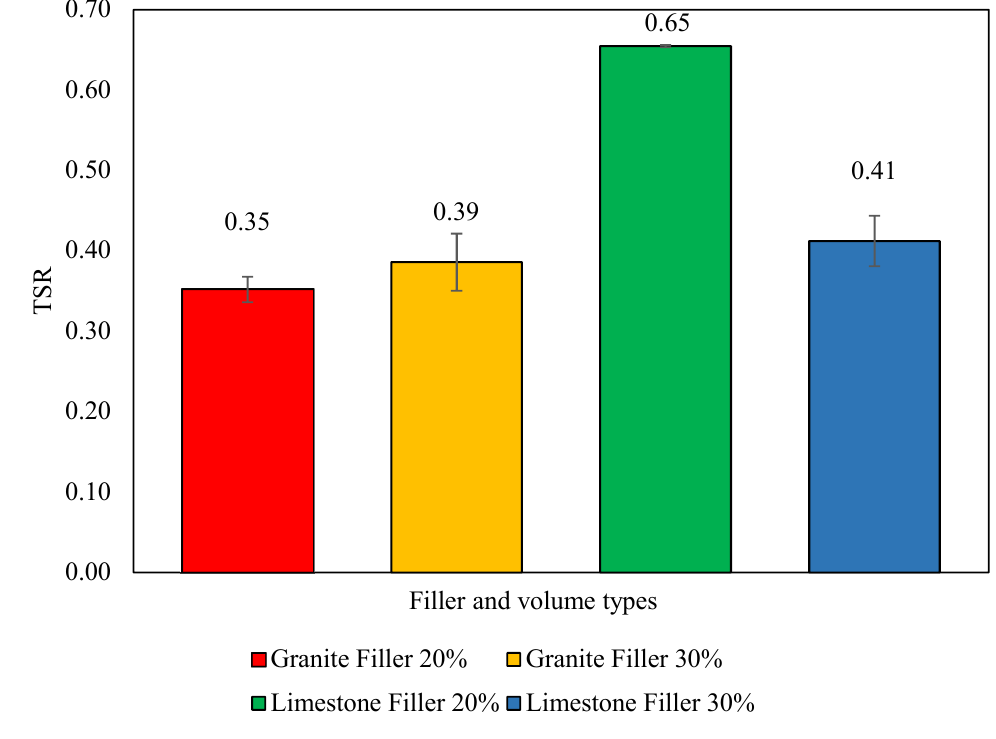
Figure 8. TSR of POTS test after moisture of asphalt mixtures for all filler types.